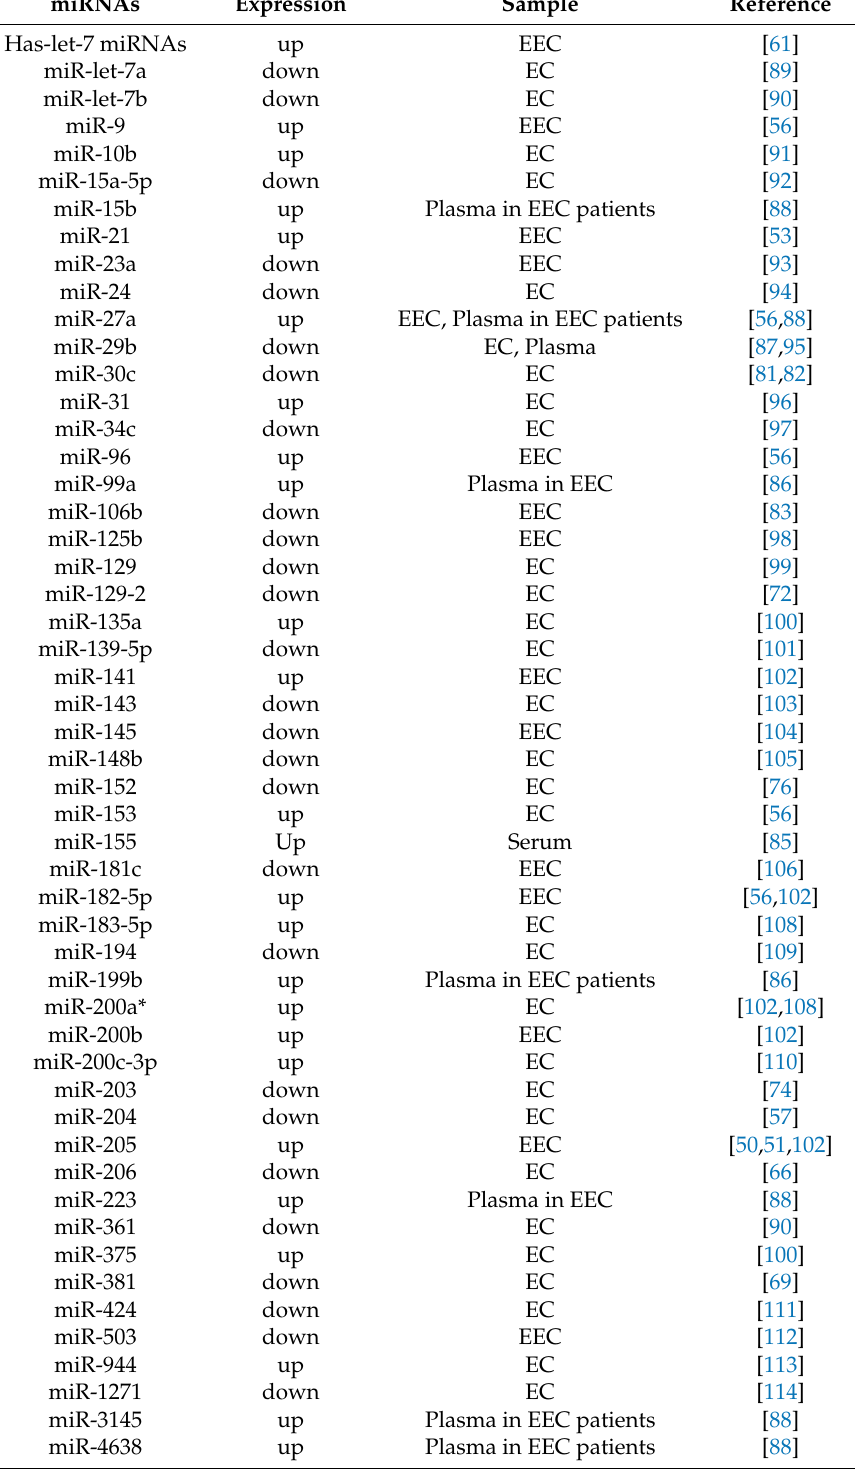
Table 2. miRNAs differentially expressed in endometrial cancer (EC) patients. miRNAs Expression